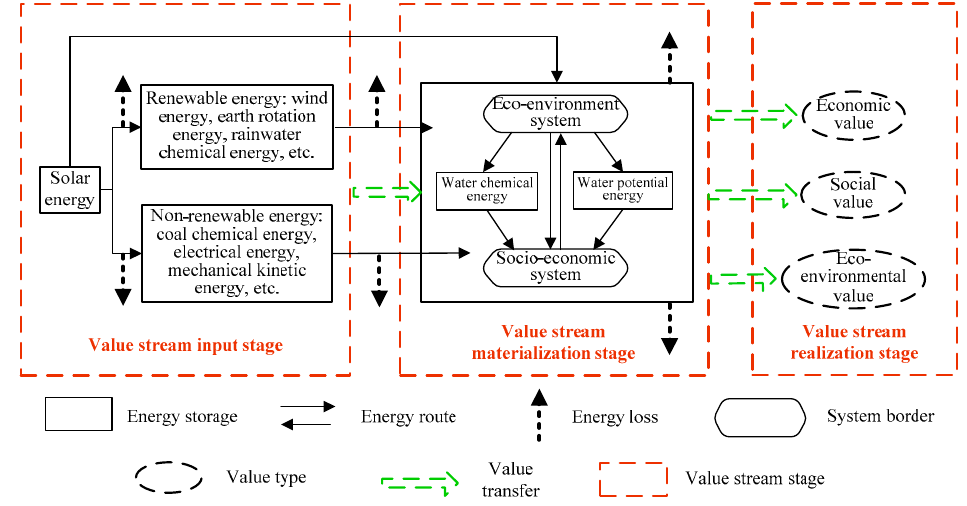
Figure 1. Value stream of the water-resource eco-economic system in the Yellow River Basin.